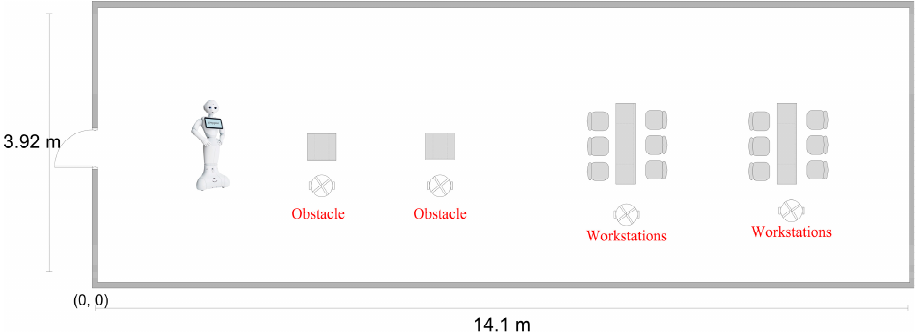
Figure 6. The actual structure of Area 1 (study area).